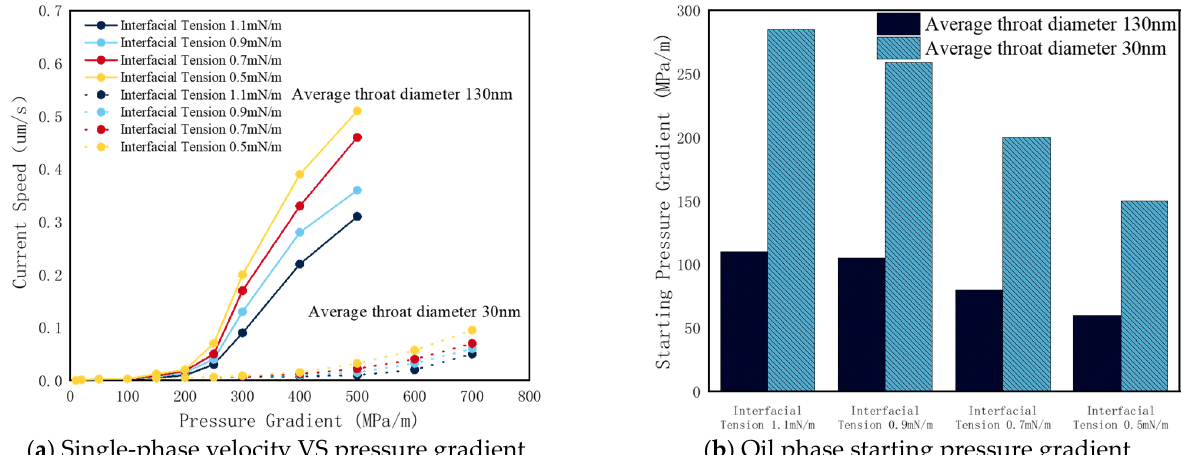
Figure 19. Fluid pressure diagram under different interfacial tension. It can be seen from Figure 20 that with the increase of interfacial tension, the oil-flow area decreases, and the pressure in large-size pores increases. The adsorption force of oil on the pore wall increases, and the flow characteristics become more complicated.